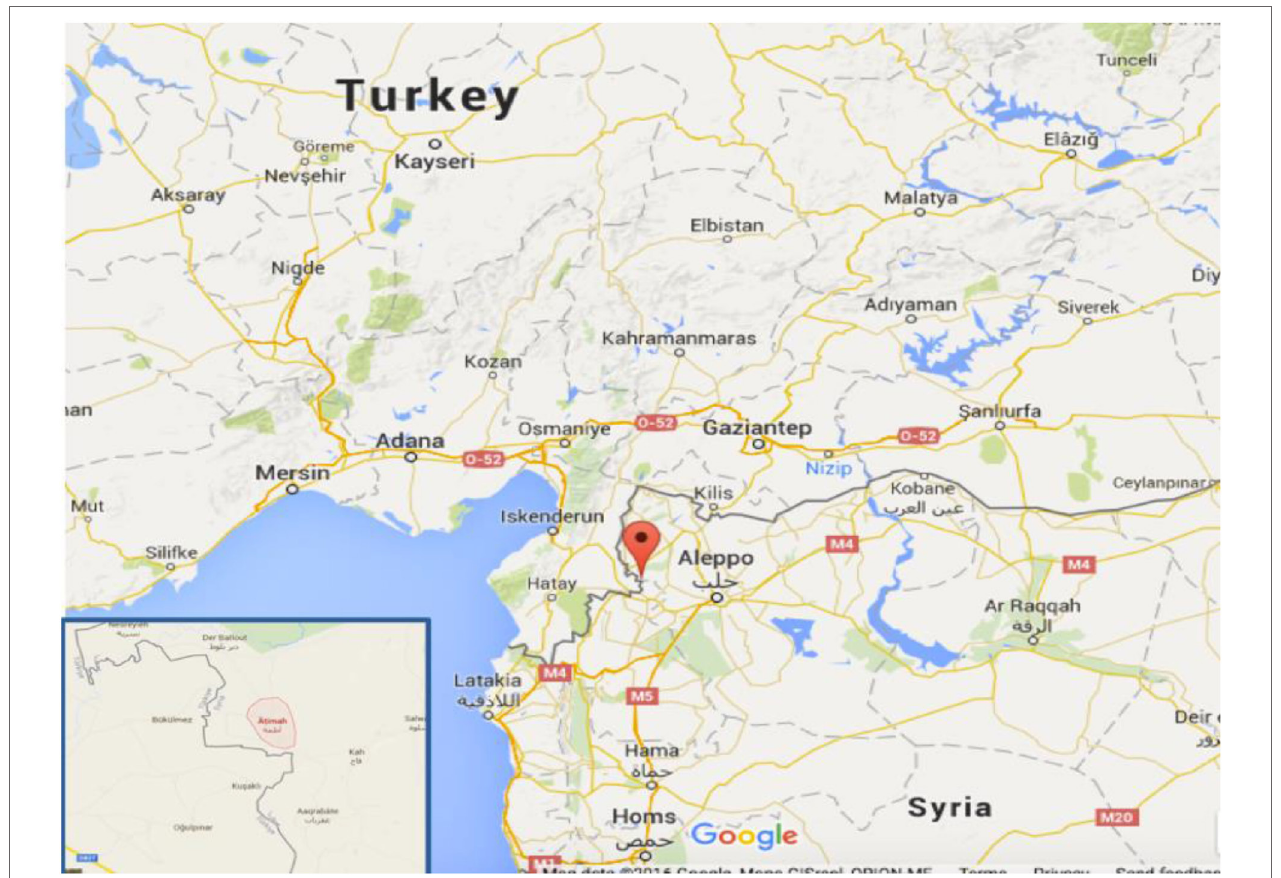
FiguRe 1 | Syrian–Turkish boarder, map depicting the location of Atimah where the Brotherhood Medical Center is operating (Source: Google Maps).